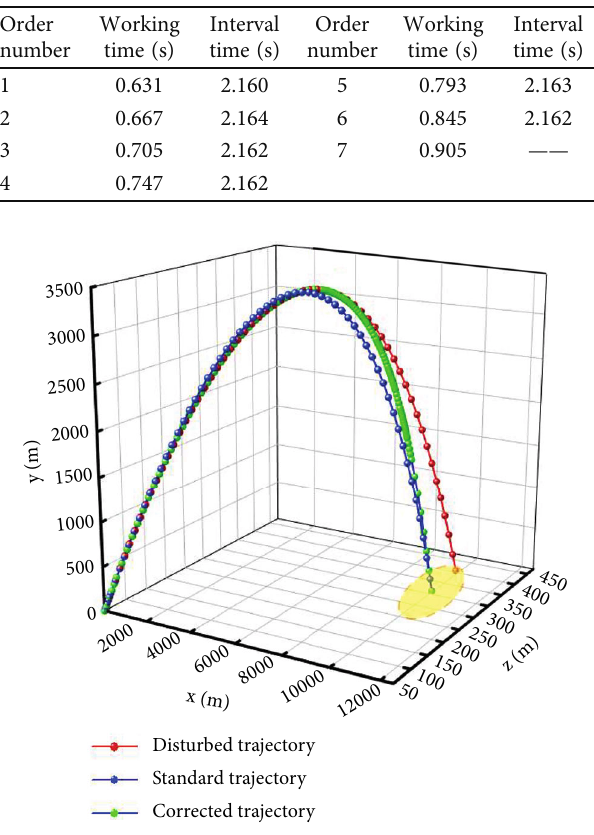
Figure 11: The trajectory curves of the projectile under three di ff erent